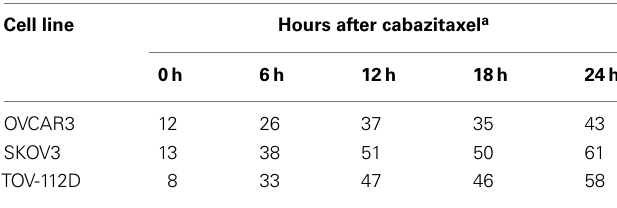
Table 1 | Redistributed G2/M cell cycle proportion after 6-h 1 µ M cabazitaxel exposure